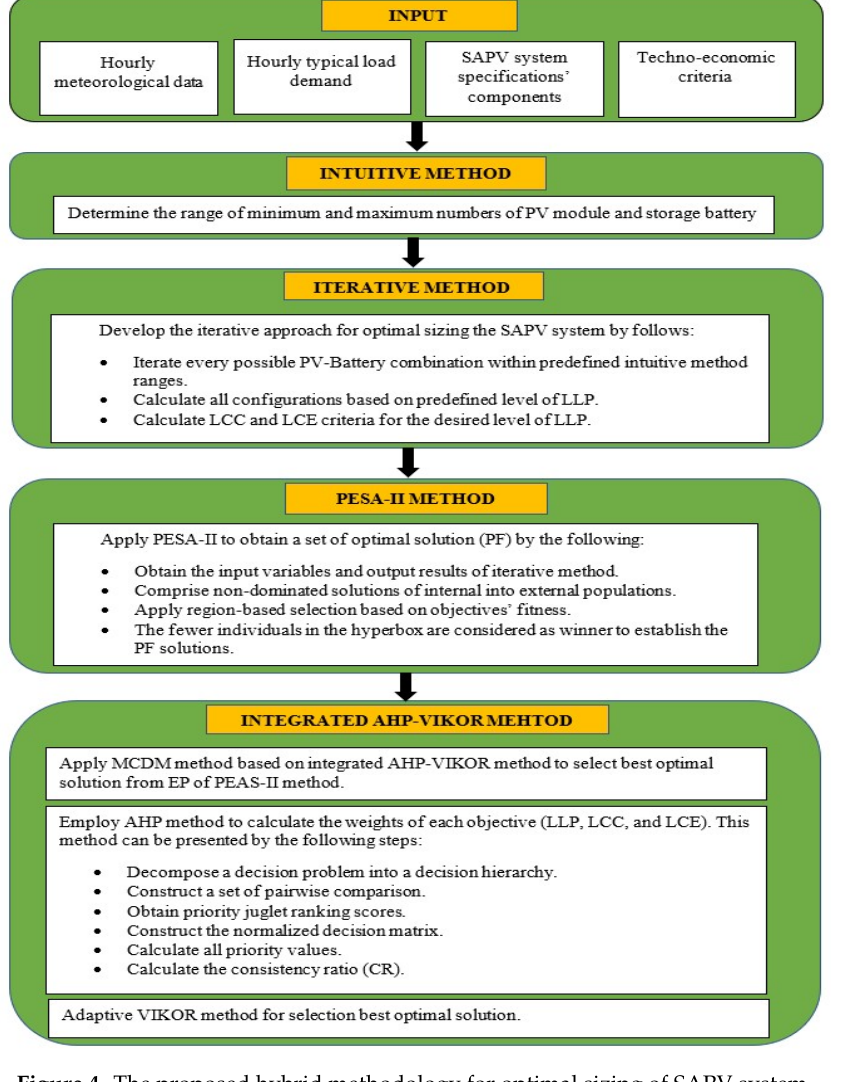
Figure 4. The proposed hybrid methodology for optimal sizing of SAPV system.